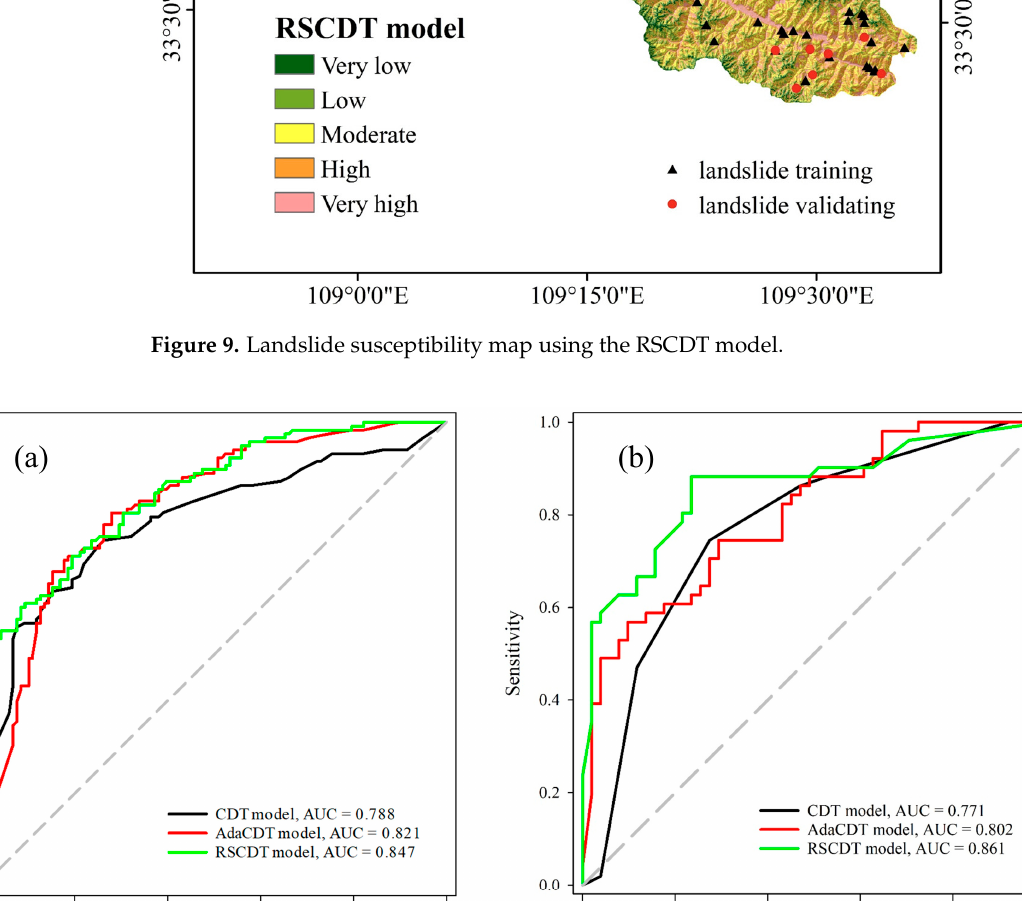
Table 5. ROC analysis of CDT, AdaCDT, and RSCDT models using training data.